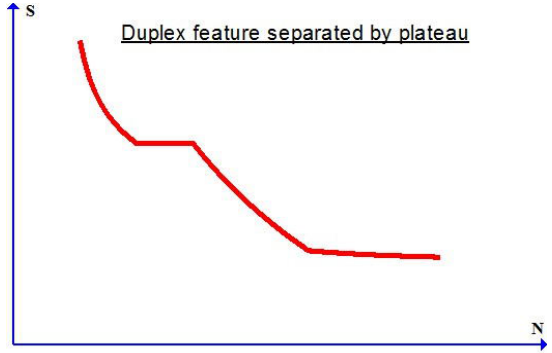
Figure 2. S-N curve displaying the duplex feature from low to high cycle fatigue